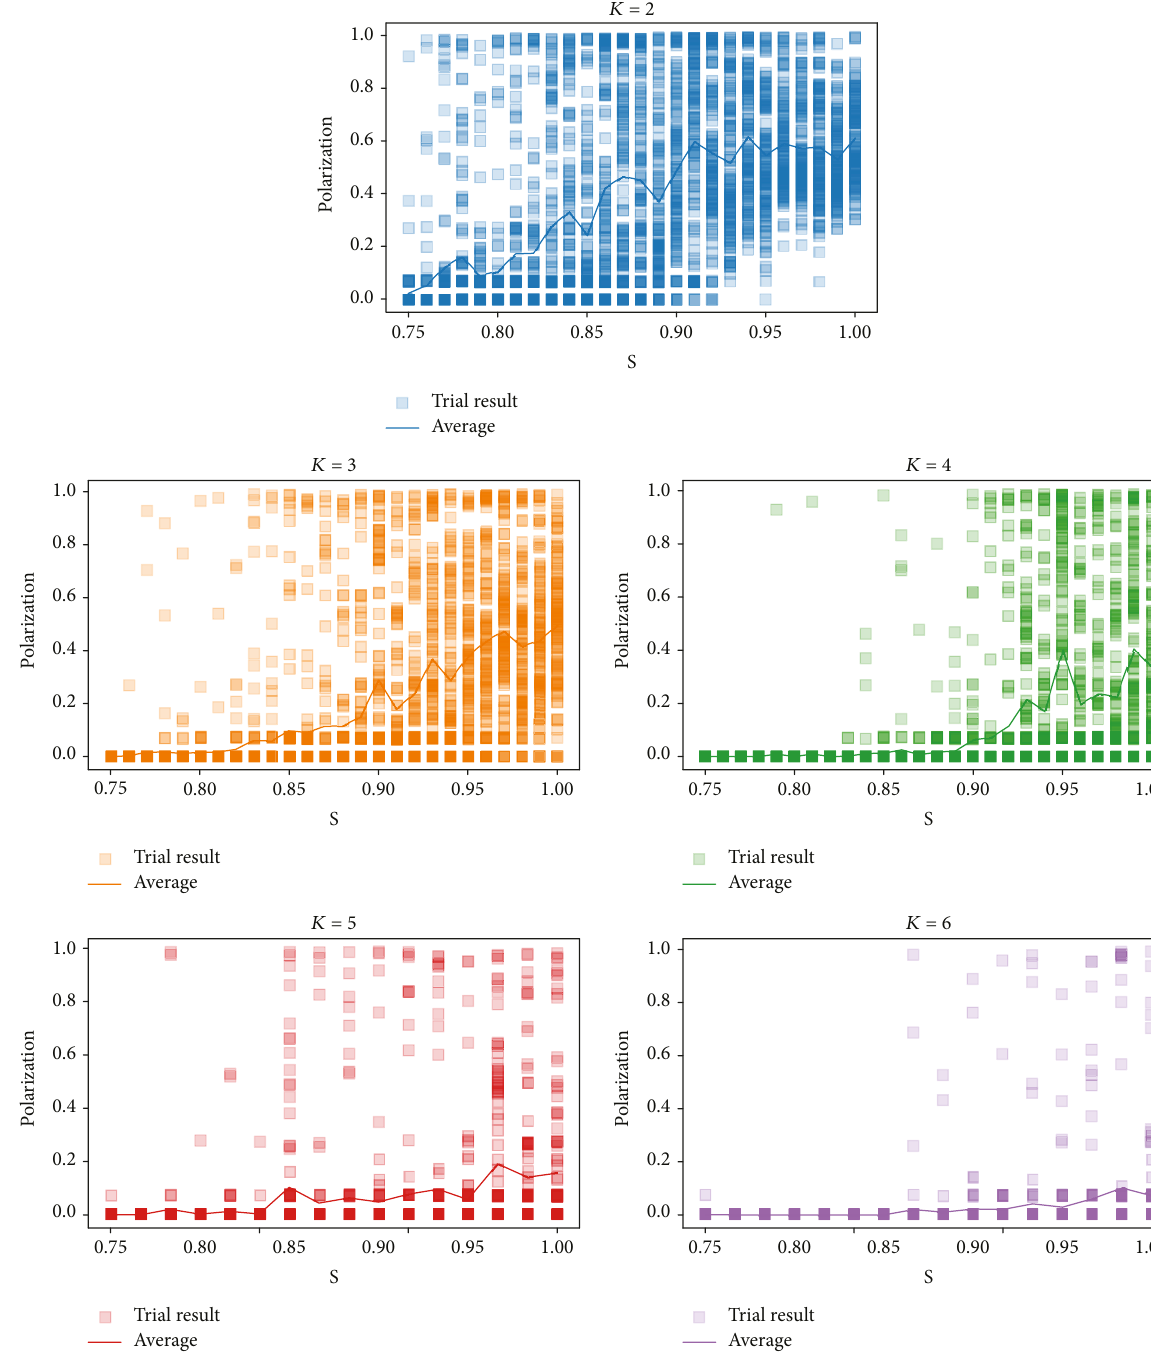
Figure 9: Final polarization of individual trial runs and averages from Figure